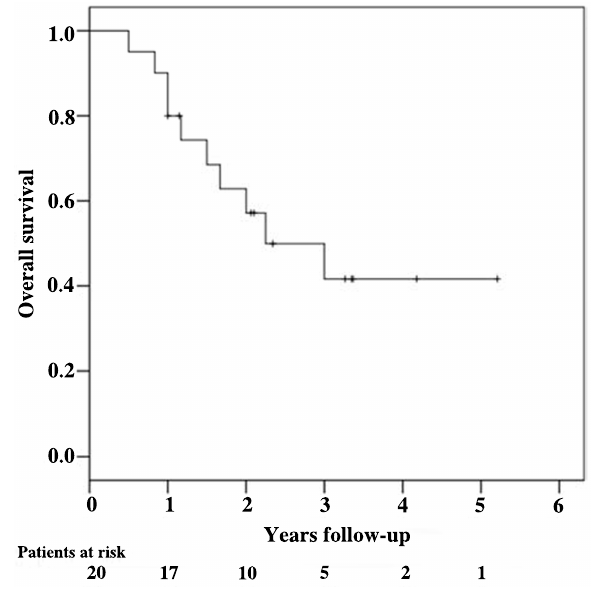
FIGURE 3 | Kaplan–Meier plot of overall